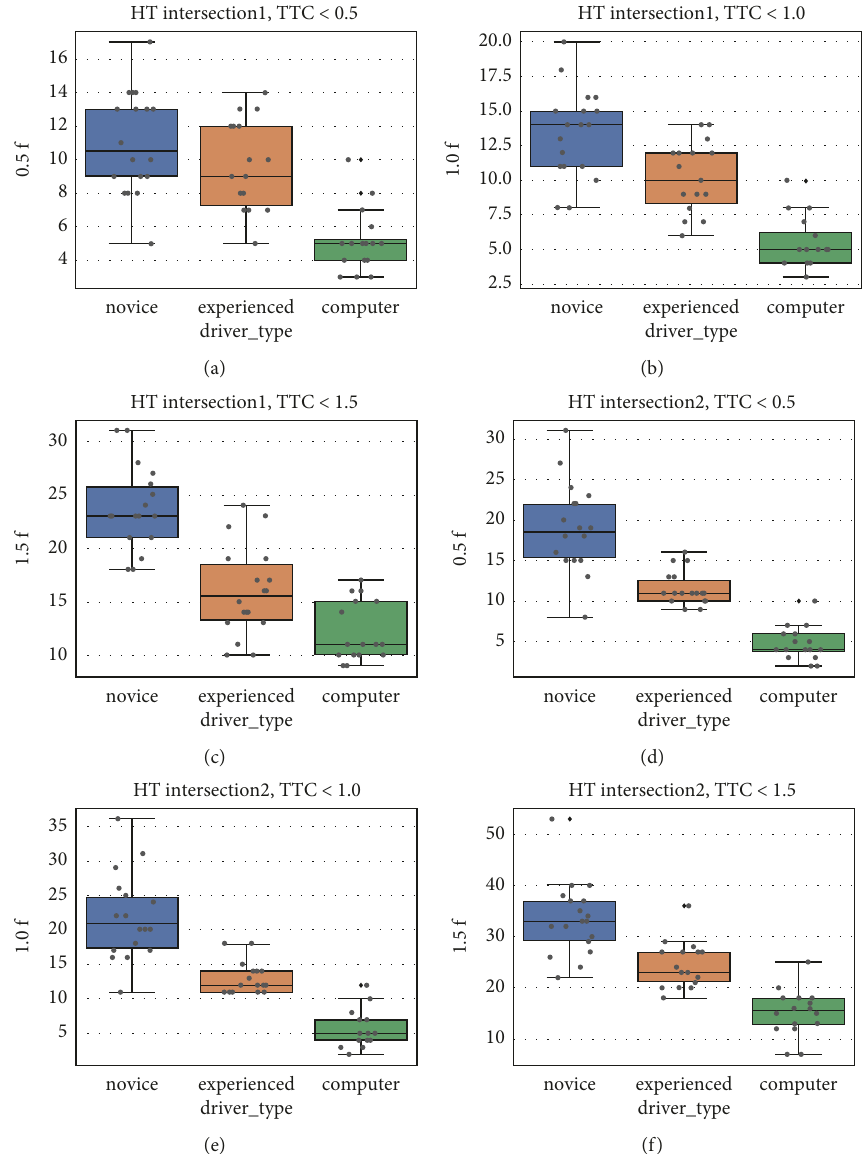
Figure 6: The number of risky driving behavior at the intersections depending on a different TTC value.